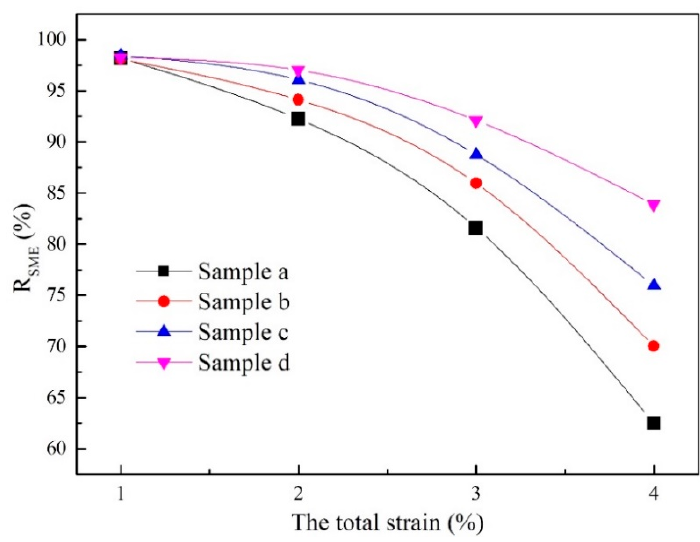
Figure 6. The R SME curves of samples with different total strain.